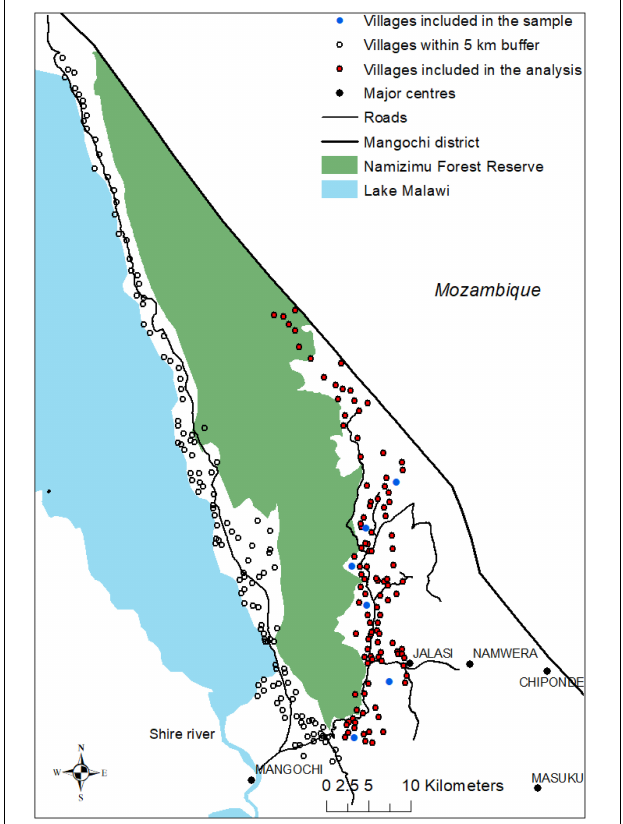
FIGURE 1 | Case-study area. The map includes a visualisation of Namizimu Forest Reserve boundaries and all the villages surrounding the area that are located within a 5 km buffer. The villages included in the scenario analysis are in red while the villages where we collected primary data on consumption of forest products through household survey are in blue. The location of the blue villages is slightly shifted to guarantee compliance with research ethic